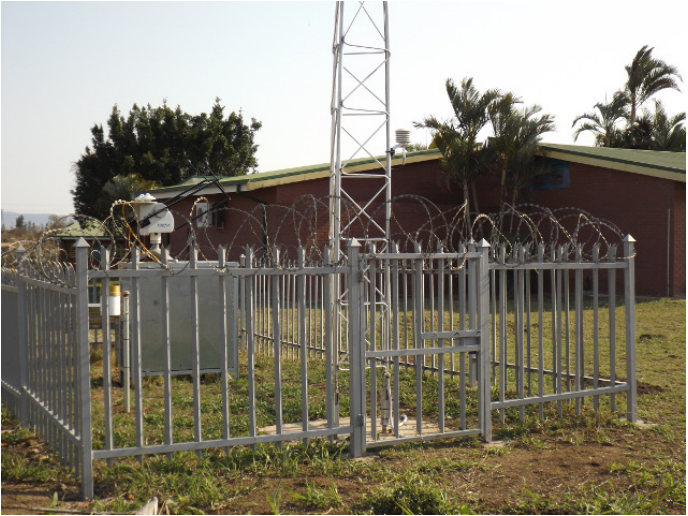
Figure 1. Picture showing the location of the Vuwani radiometric station (USAid Venda). Source: https://sauran.ac.za/, accessed 3 May